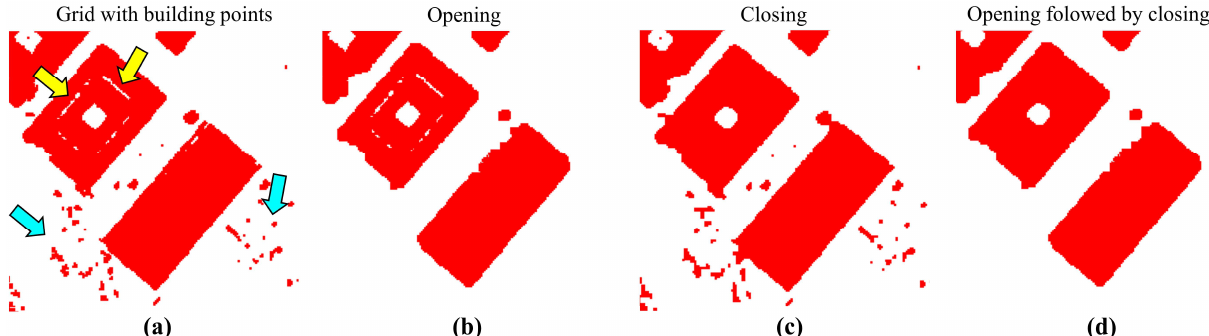
Figure 3. Example of refinement based on mathematical morphology. Grid generated using the building points (a). Result applying